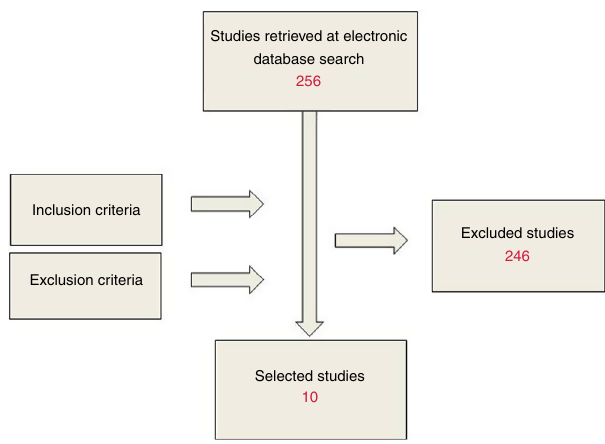
Flow chart of study